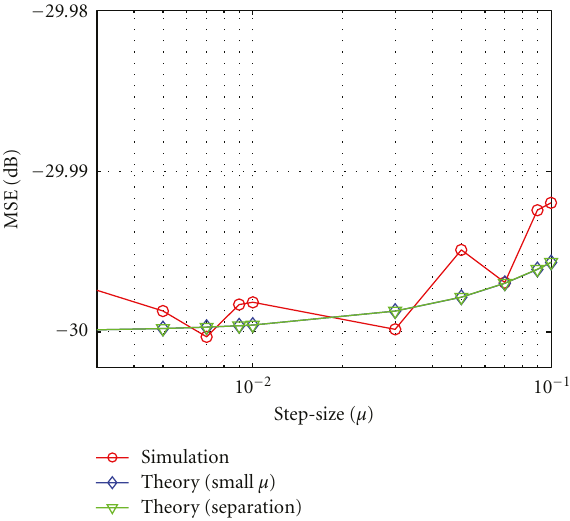
Figure 2: Theoretical and simulated MSE learning curves of the SRLMF algorithm using white Gaussian regressors with shift structure with SNR = 30